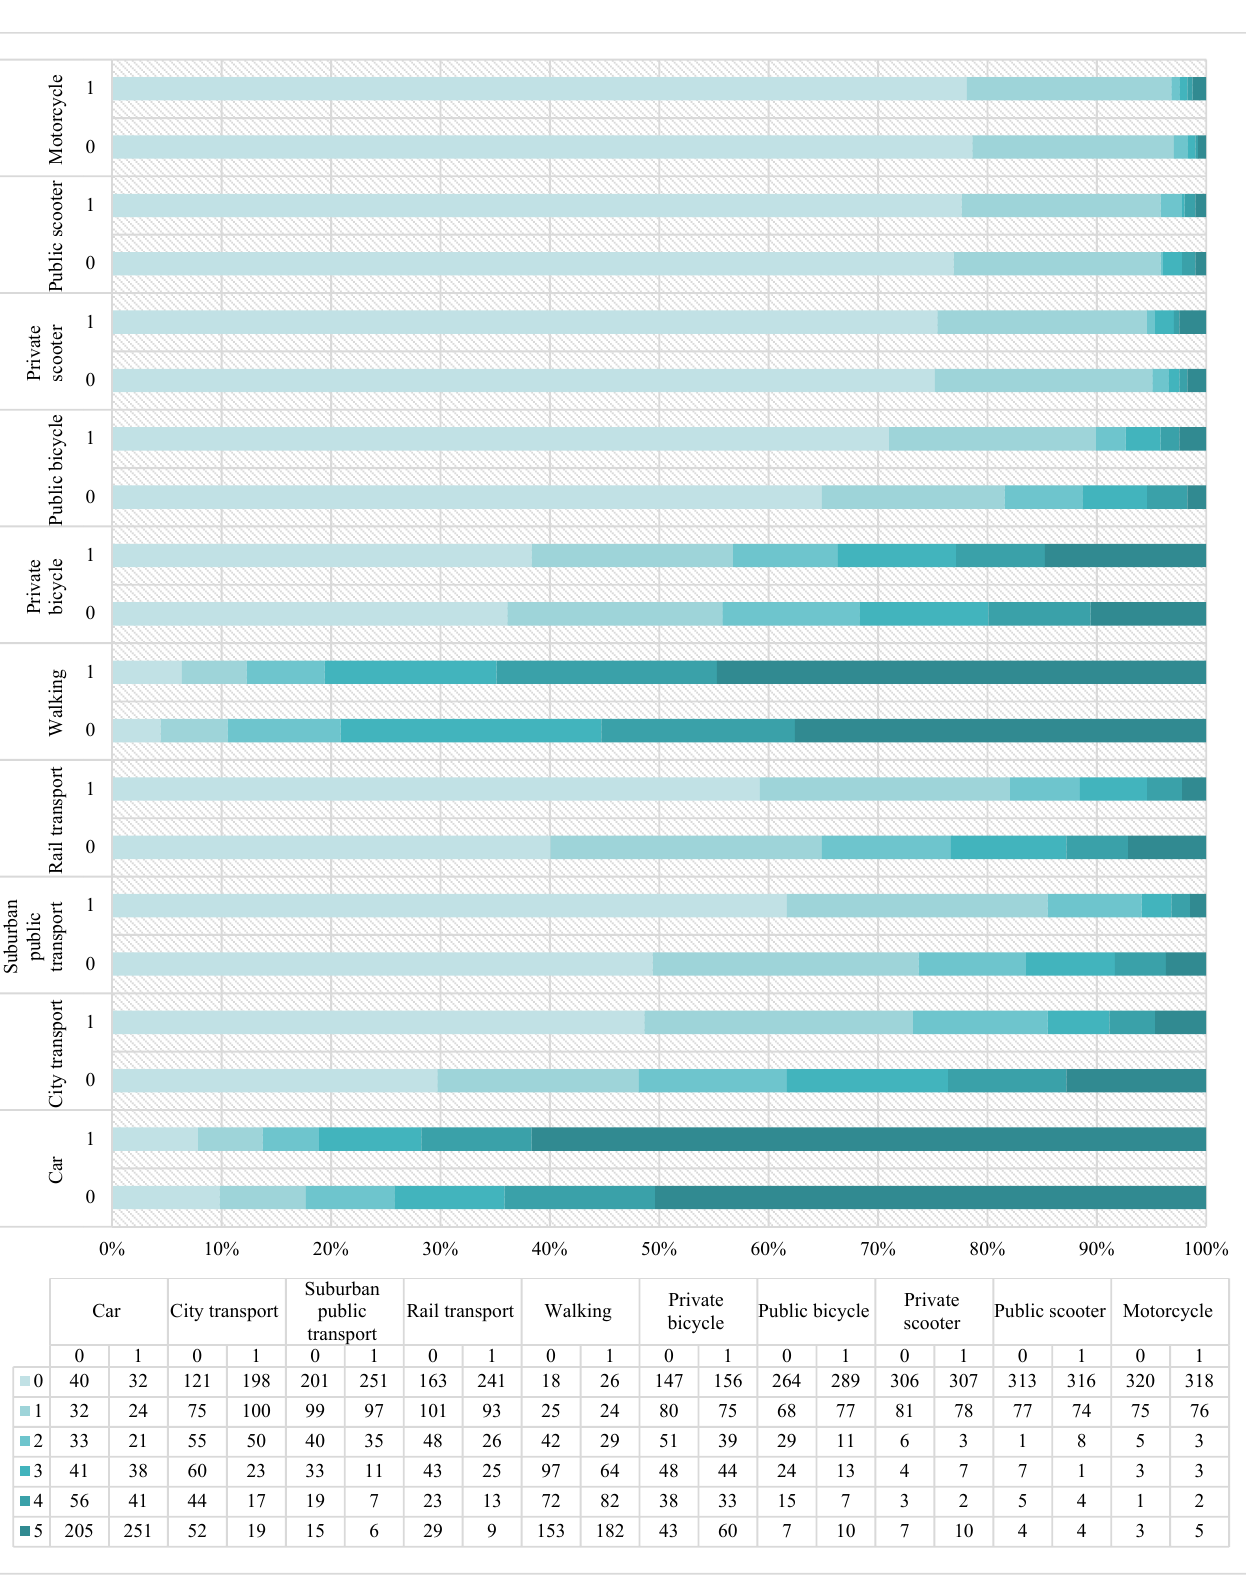
Figure 2. The preferences for using means of transport before and during the COVID-19 pandemic. Before the COVID-19 pandemic (0) and during the COVID-19 pandemic (1) on the horizontal axis. Legend: least used mode of transport (1), previously used mode of transport (2), neither nor (3) previously used mode of transport (4), and the most used mode of transport (5) on the vertical axis.